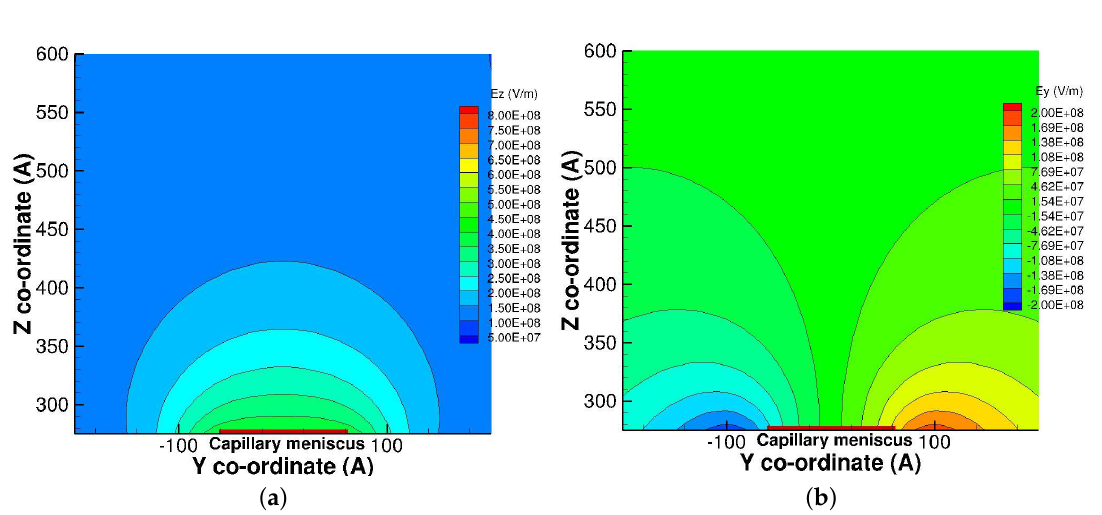
Figure 6. The electric fields generated by solving Equation (11) with the boundary conditions shown in Figure 5 and extraction voltage of − 17 V. ( a ) Normal electric field; ( b ) Radial electric